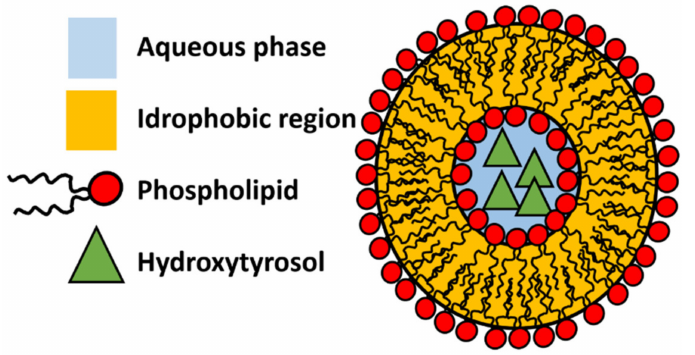
Figure 6. Schematic structure of liposome vesicles enriched with